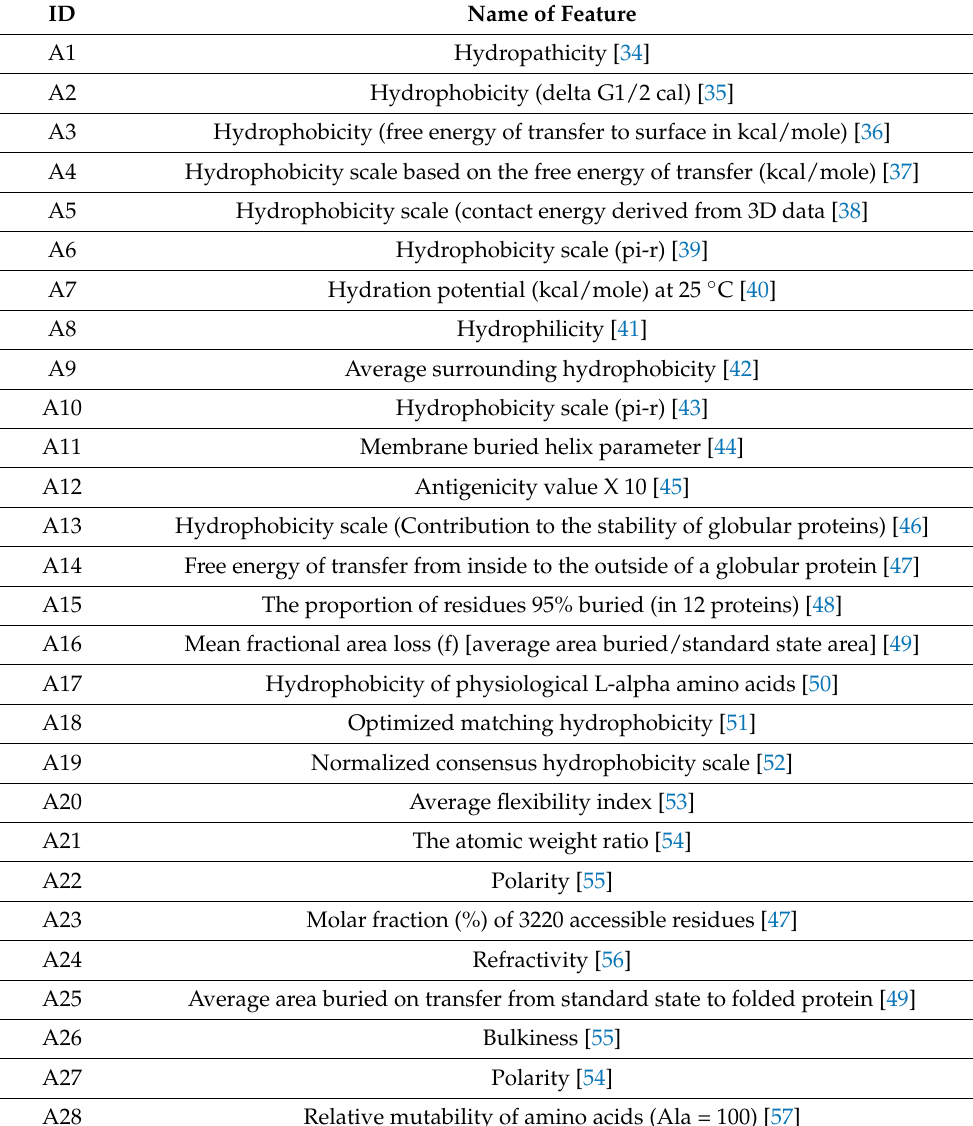
Table 1. List of features with their respective